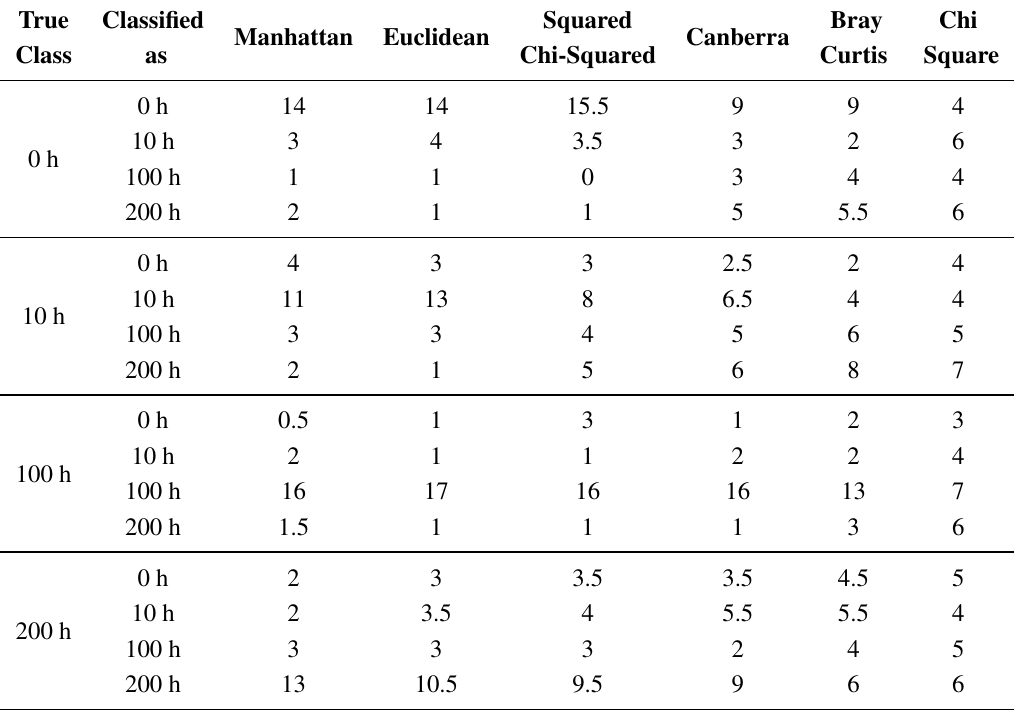
Table 5. Confusion matrix of the classification means for the 5-MHz frequency pulse echo signals at 650 ◦ C.